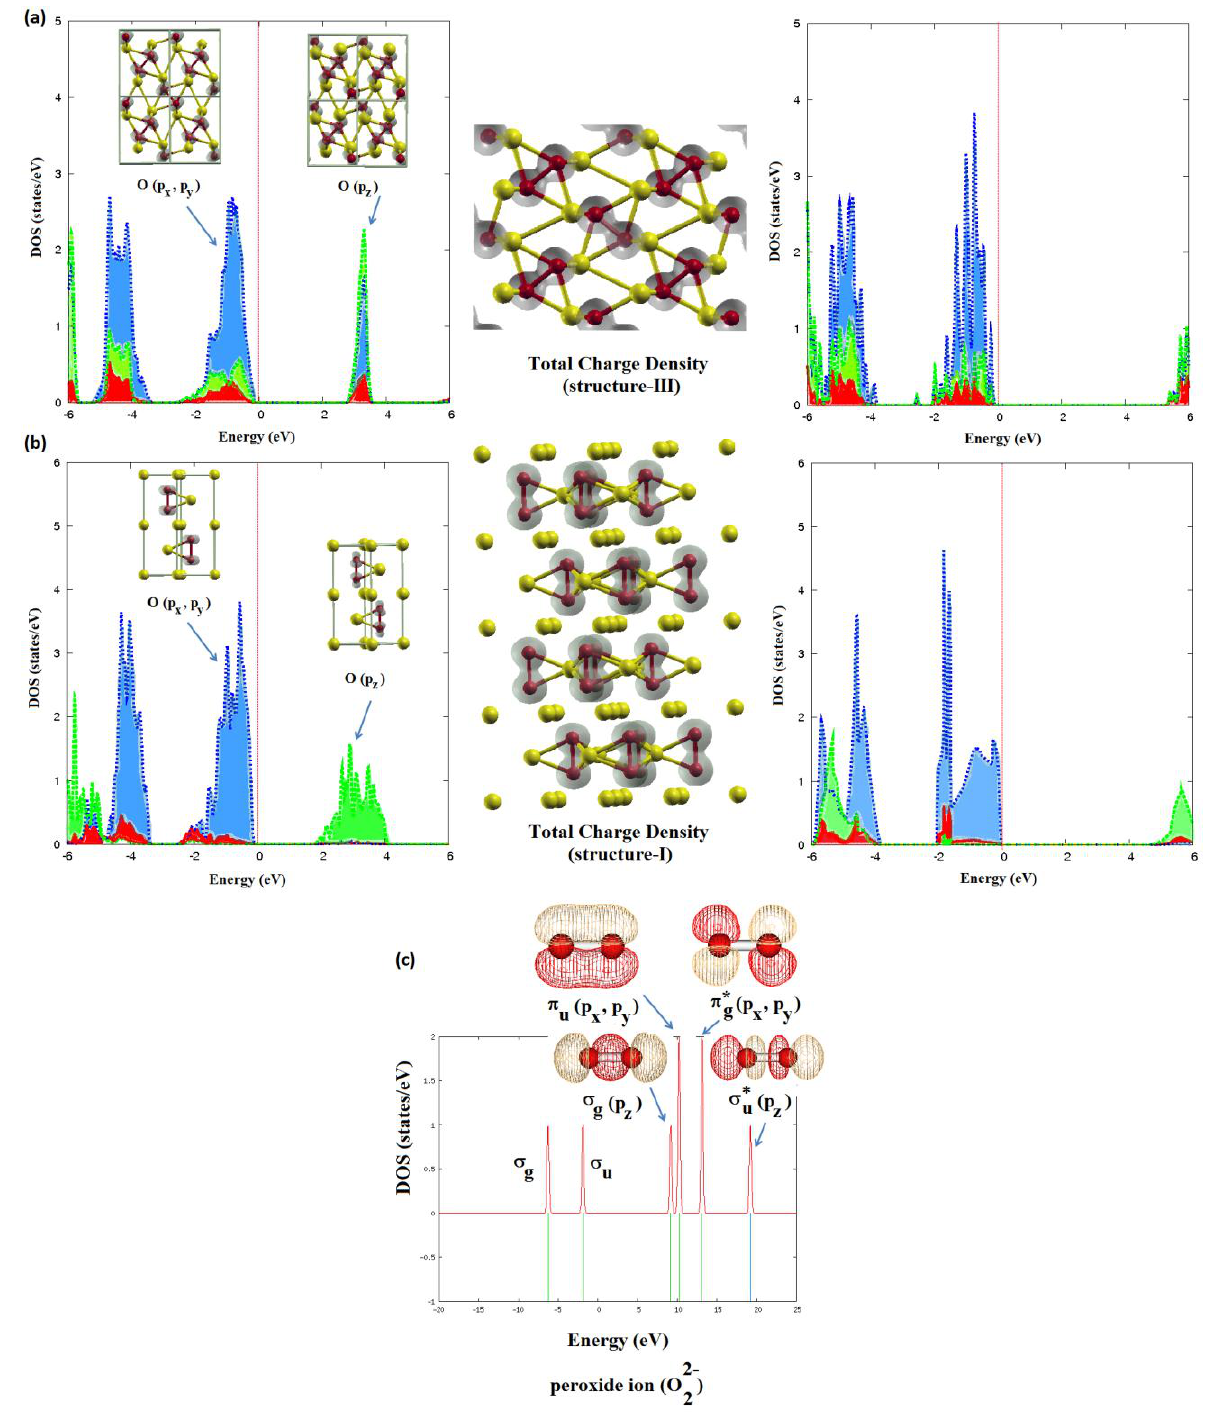
Figure 8. The electronic partial density of states (PDOS) of Li 2 O 2 structure-III ( a ) and structure-I ( b ) for oxygen ( p x , p y ) (blue), p z (green) and lithium (red) contributions from PBE (left) and HSE06 (right) calculations with the Fermi-level ( E f ) set to zero. The inset is the figure of partial charge density (at an isovalue ρ ~ 0.4 e/Å 3 ) at the vicinity of E f that mostly corresponds to oxygen p -character. The total charge density of the system (center) is set to be at an isovalue ρ ~ 0.9 e/Å 3 ; ( c ) The representative molecular orbitals and DOS of a peroxide ion O 22− in the PBE calculation. The green and blue-lines represent the occupied and unoccupied orbitals respectively in the